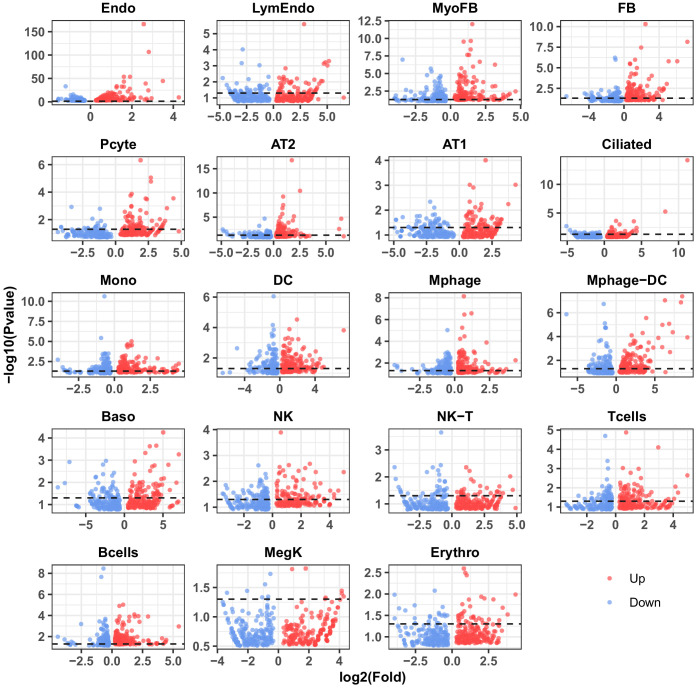
p-value distribution of the top 200 up- and downregulated IH-responsive genes in 19 lung cell types.Each red or blue point indicates one up- or downregulated gene. The black dashed line indicates a p-value of 0.05.